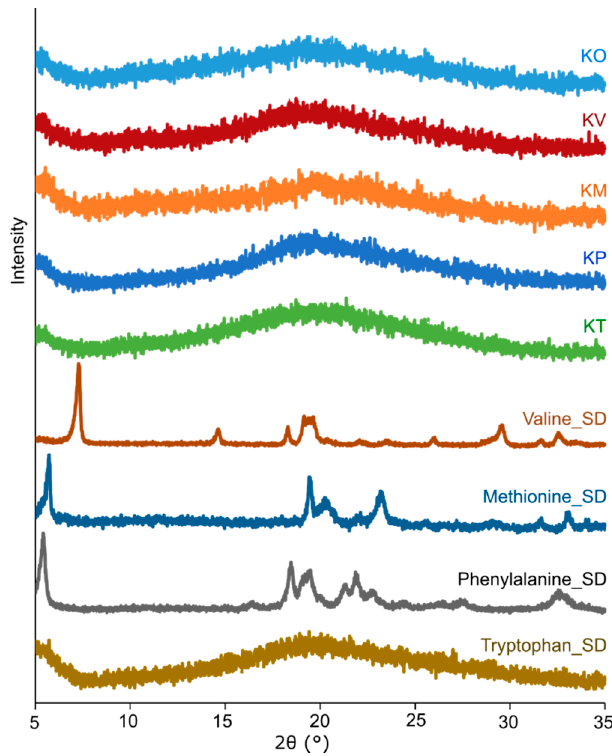
Figure 2. Representative X-ray diffractograms (XRD) of the spray-dried formulations (kanamycin only (KO), kanamycin-valine (KV), kanamycin-methionine (KM), kanamycin-phenylalanine (KP), and kanamycin-tryptophan (KT)) and spray-dried (SD) amino acids (methionine (Methionine_SD), valine (Valine_SD), phenylalanine (Phenylalanine_SD), and tryptophan (Tryptophan_SD)). Table 2. Water content and glass transition of the di ff erent spray-dried particles. Values are expressed as mean ± standard